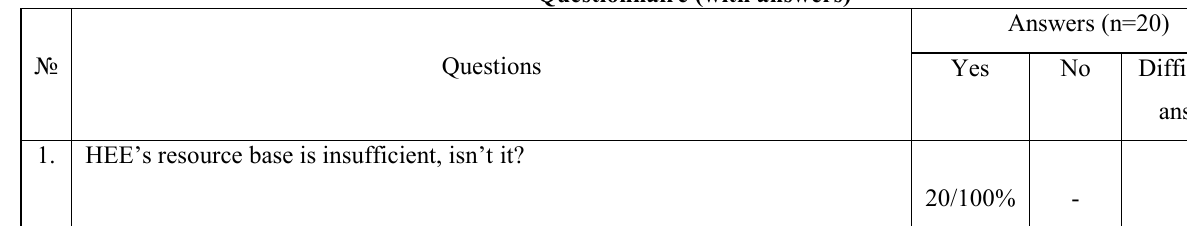
Questionnaire (with